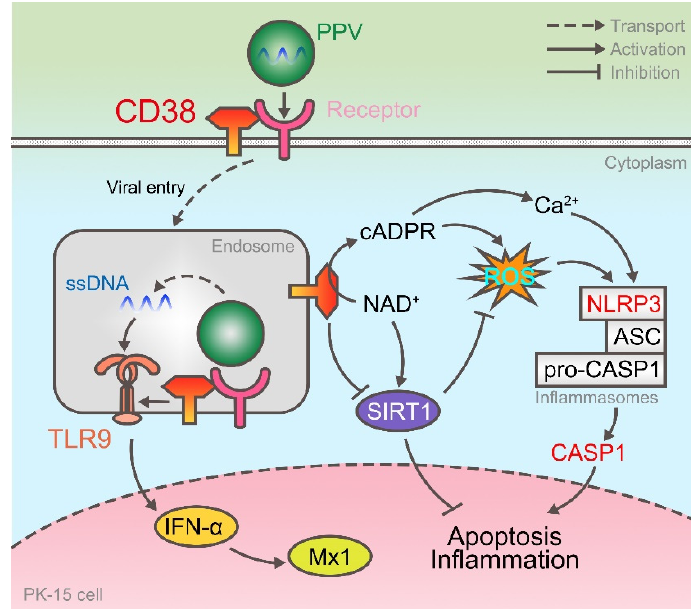
Figure 5. CD38 enhances TLR9 expression and activates NLRP3 inflammasome after PPV infection. On the one hand, after PPV enters the cell, its ssDNA is recognized by TLR9 and activates the expression of IFN- α and Mx1, and CD38 participates in it as the upstream of TLR9. On the other hand, CD38 enhances ROS levels and activates NLRP3 inflammasome by cyclizing ADPR and inhibiting SIRT1 expression.